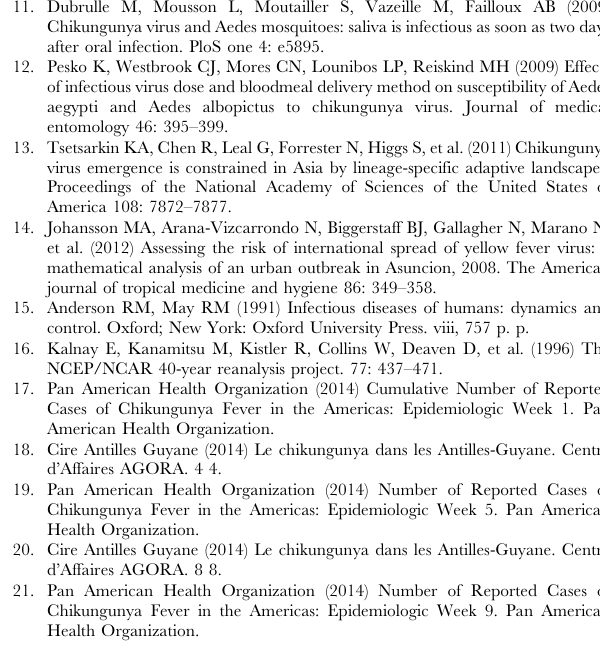
Figure 4. Probability of local transmission of chikungunya virus by location. A. Location-specific mean estimates (points) and 95% percentiles (lines) of the cumulative predicted probabilities of local transmission for the 50 locations most likely to have had introduced transmission over the time period December 2013–April 2014. Locations which had reported locally-acquired cases as of May 2 are marked in red. B. Location- specific mean estimates (points) and 95% percentiles (lines) of the predicted probabilities for the 50 locations most likely to have had introduced transmission in April. C. The mean probabilities of local transmission for all locations in the Americas with p . 0.1 in April. BVI: British Virgin Islands; USVI: U.S. Virgin